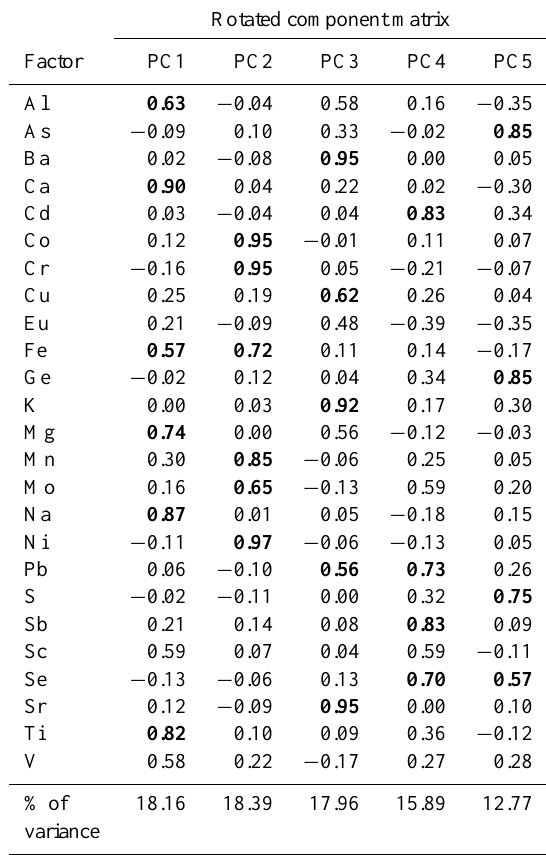
Table 1. Average concentration of elements with one standard de- viation (µgm − 3 ) in PM 2 . 5 and TSP.